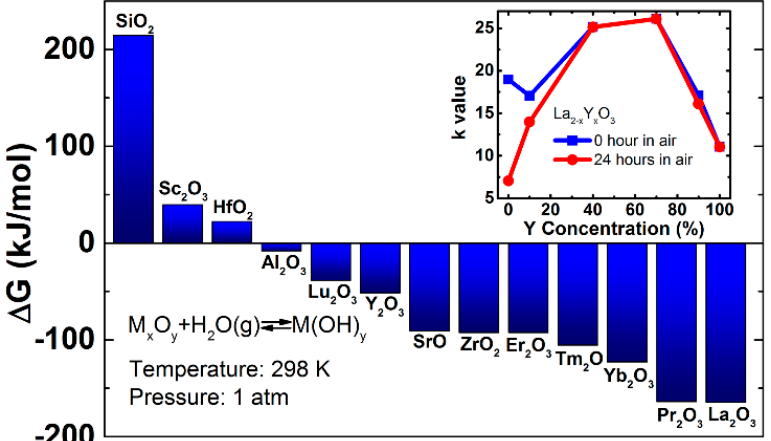
Figure 6. Gibbs free energy change of moisture reaction in high-k oxides under standard conditions [39].